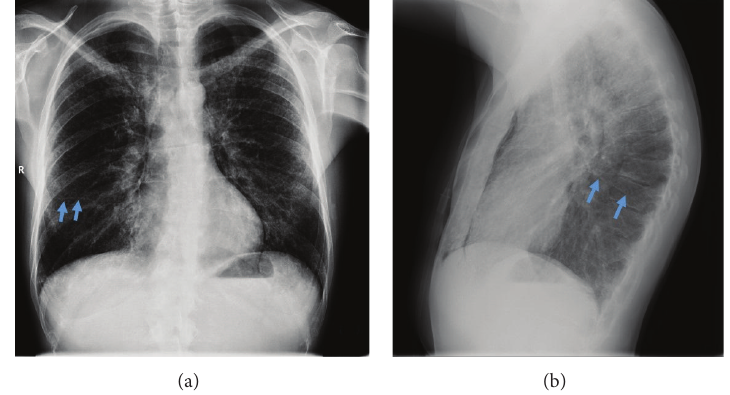
Figure 2: Plain X-rays. (a) anteroposterior X-ray; (b) lateral X-ray. Blue arrows show the superior accessory fissures (R = right side).